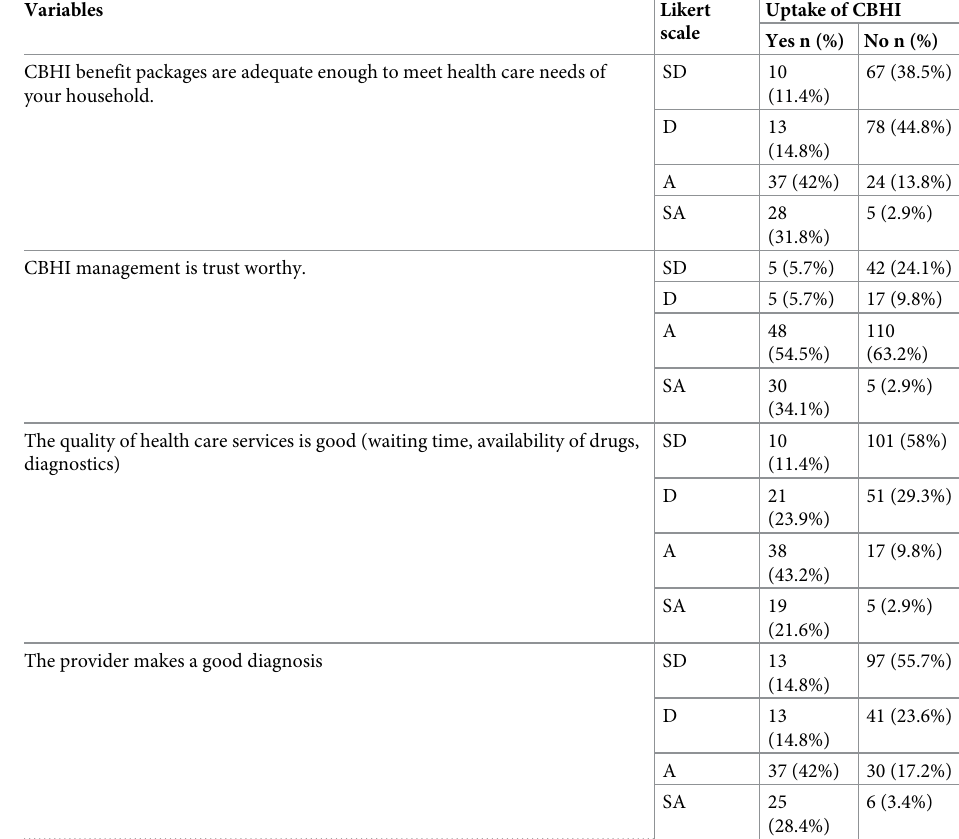
Table 1. Perception factors and Likert scale score of respondents for inrolment of household to CBHI in Tach- Armachiho district, North Gondar, Ethiopia, 2019.